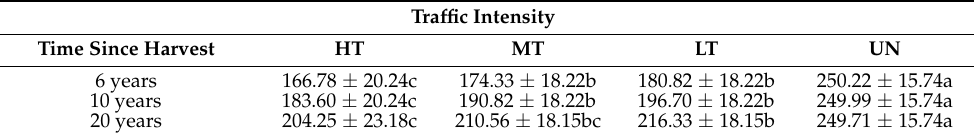
Table 2. Mean values ( ± SE) of total nematodes (in 100 g soil) in different years after harvest under different traffic intensities; HT: skid trail with high traffic intensity, MT: skid trail with medium traffic intensity, LT: skid trail with low traffic intensity, and UN: undisturbed area.